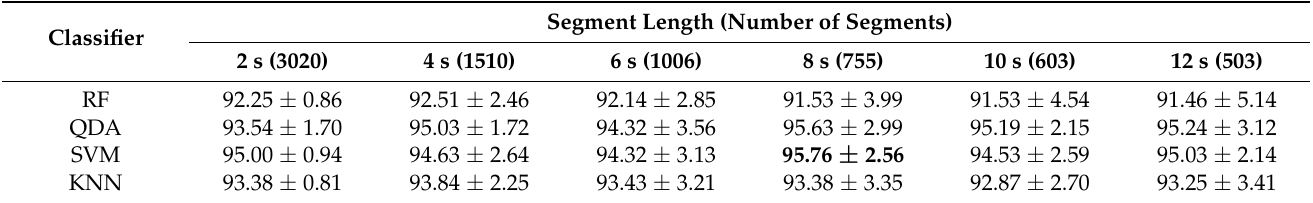
Table 11. The effect of segment length on the classification performance of on–PD vs. HC.